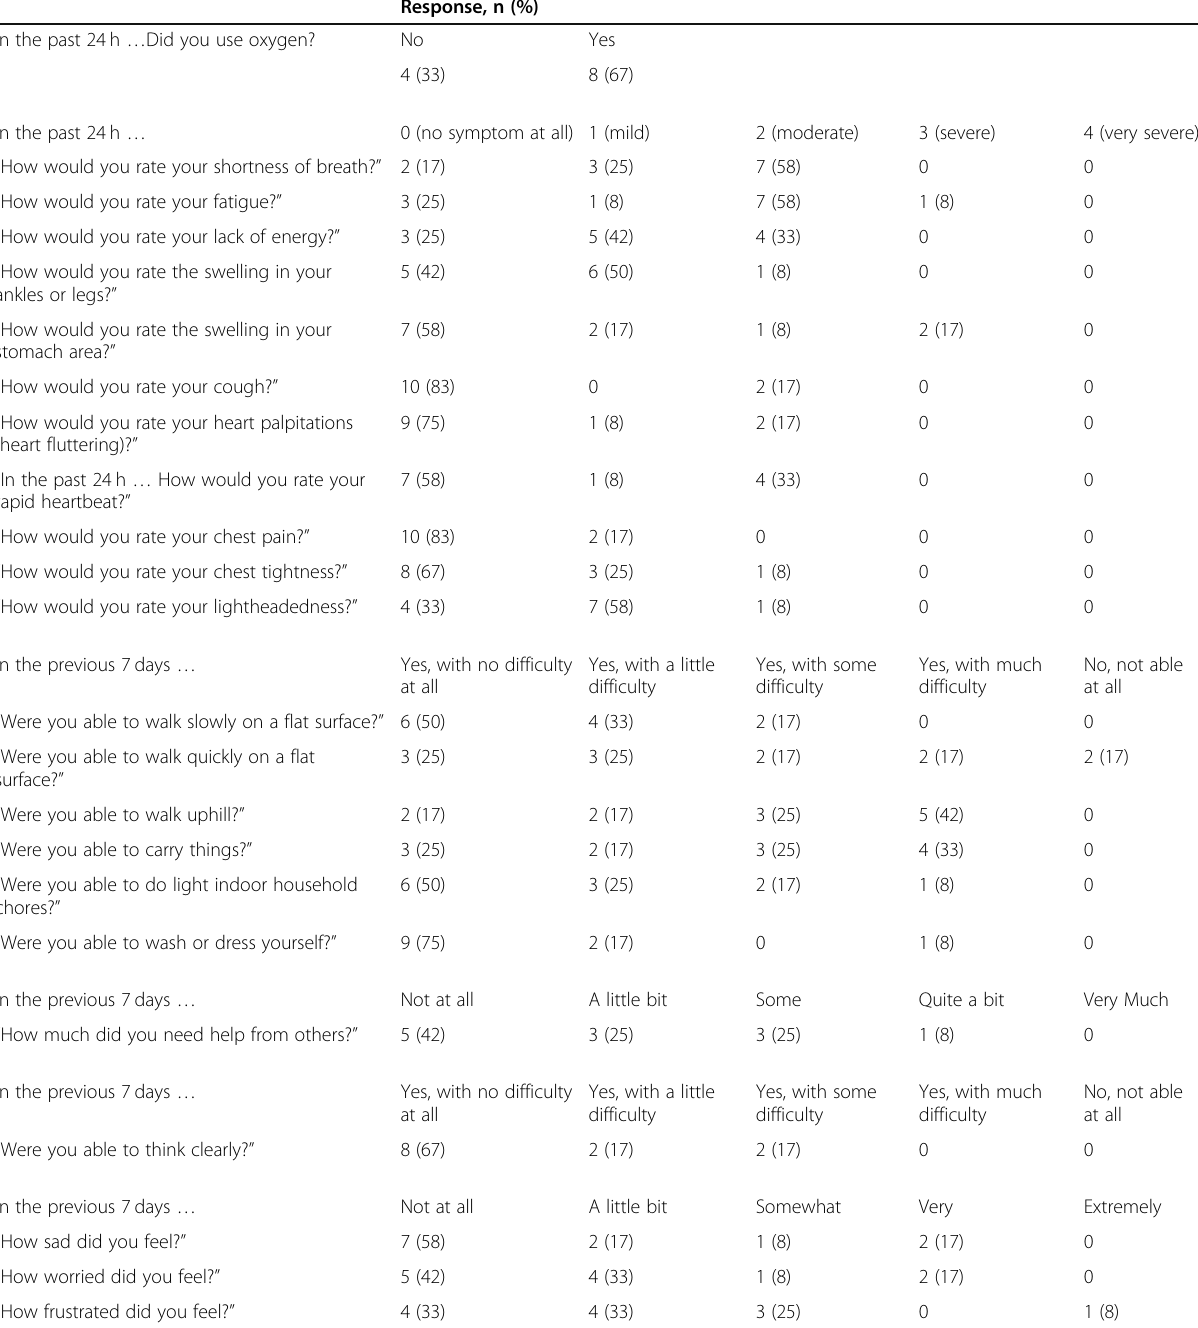
Table 4 PAH-SYMPACT ™